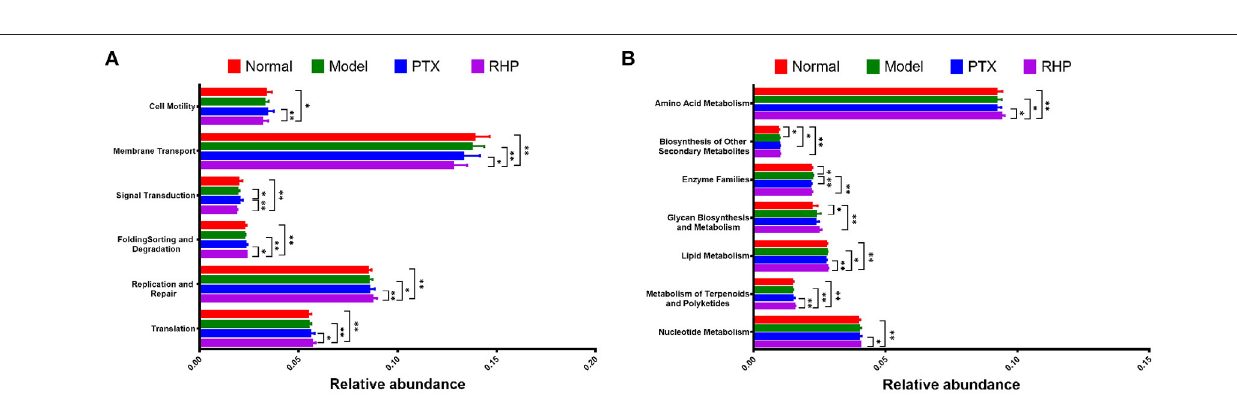
FIGURE 7 | Metabolic pathway enrichment analysis. The predicted genes and their functions were aligned to KEGG database, and the relative expressions for each pathway were compared. (A) The most affected pathway for cellular processes (cell motility), environmental information processing (membrane transport, signal transduction), and genetic information processing (folding sorting and degradation, replication and repair, and translation). (B) The most affected pathway for metabolism. Values were represented the means ± SD. * p < 0.05 and ** p <